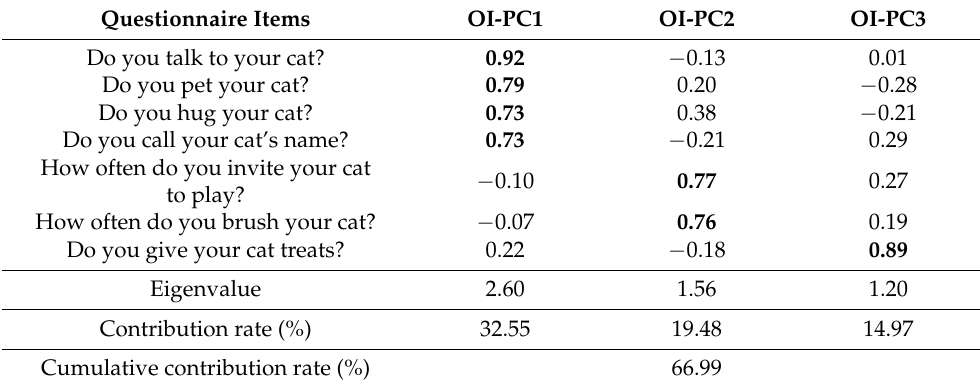
Table 4. Principal component loadings and contributions to owner-initiated